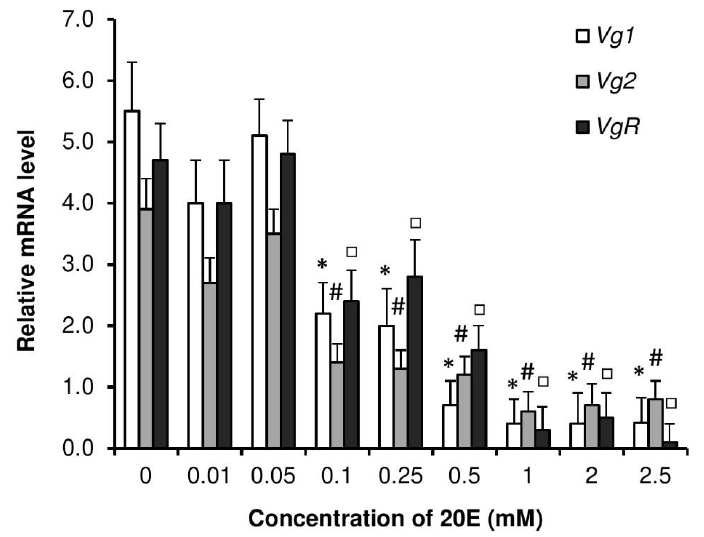
Figure 9. Dose response for reduction by 20E. Expression of Vg1 , Vg2, and VgR mRNA in P. americana female fat body 4 days after injection with 10 µL of the different doses of 20E. Control roaches were injected with 10 µL of ca. 0.1% EtOH solvent. Data are shown as mean ± SEM. Columns with symbols (*: Vg1 ; #: Vg2 ; □: VgR ) are significantly different at p < 0.05, compared to 0 concentration, using Tukey’s test.